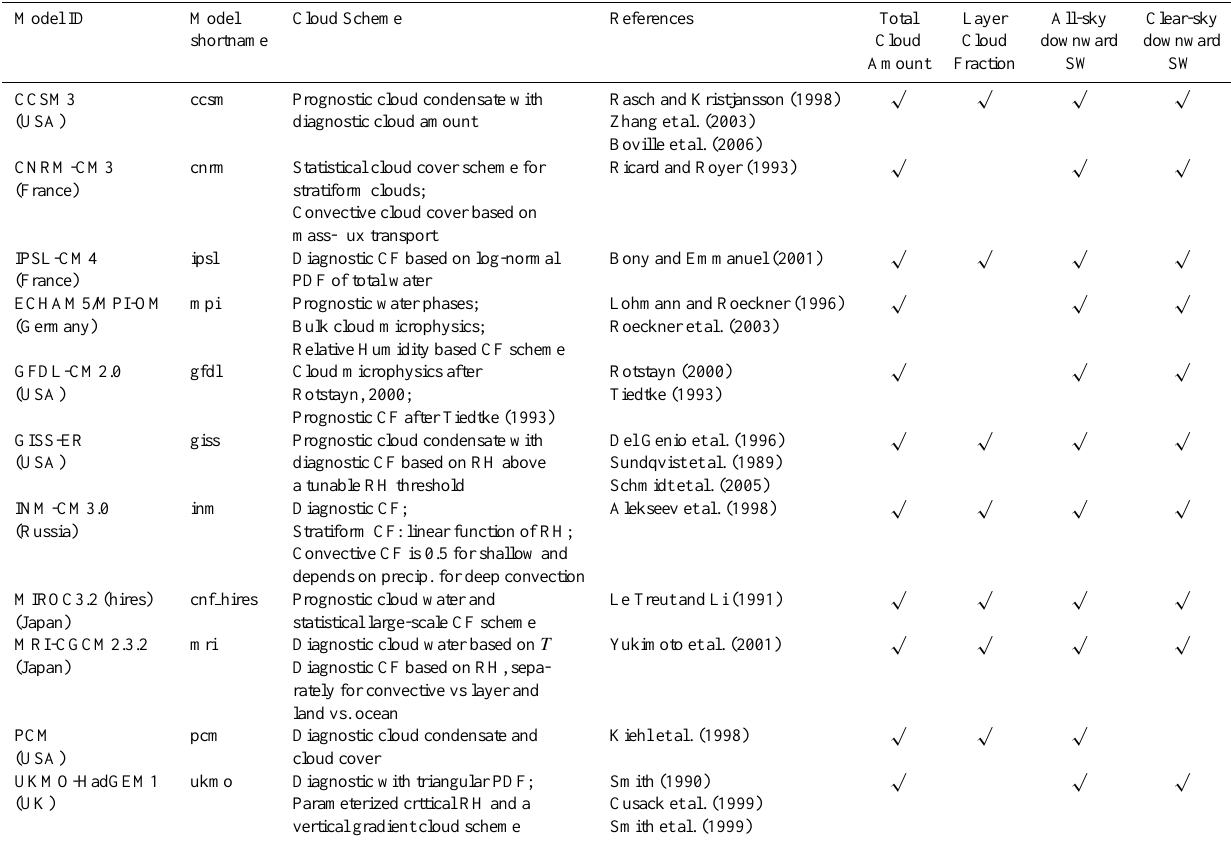
Table 1. A summary of cloud fraction scheme and data availability in IPCC AR4 GCMs used in this study. Model